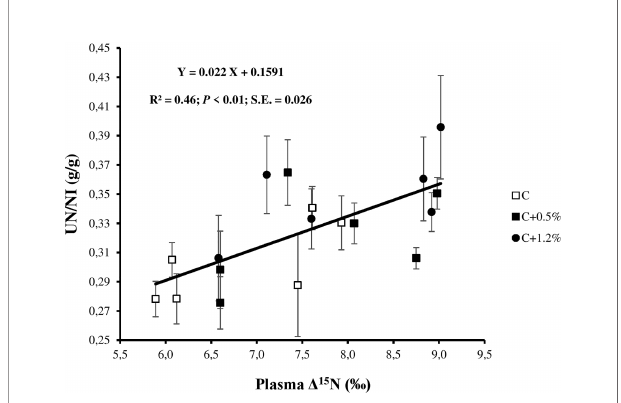
FIGURE 4 | Relationship between urinary nitrogen (N; UN) to N intake (NI) ratio (UN/NI) and plasma N isotopic discrimination (plasma D 15 N) for individual observations of the sheep offered three different levels of non-protein N: C, control dietary treatment with maintenance N intake (NI) allowance; C+0.5%, control dietary treatment with maintenance plus an additional 15% NI allowance; C+1.2%, control dietary treatment with maintenance plus an additional 33% NI allowance. The error bars show